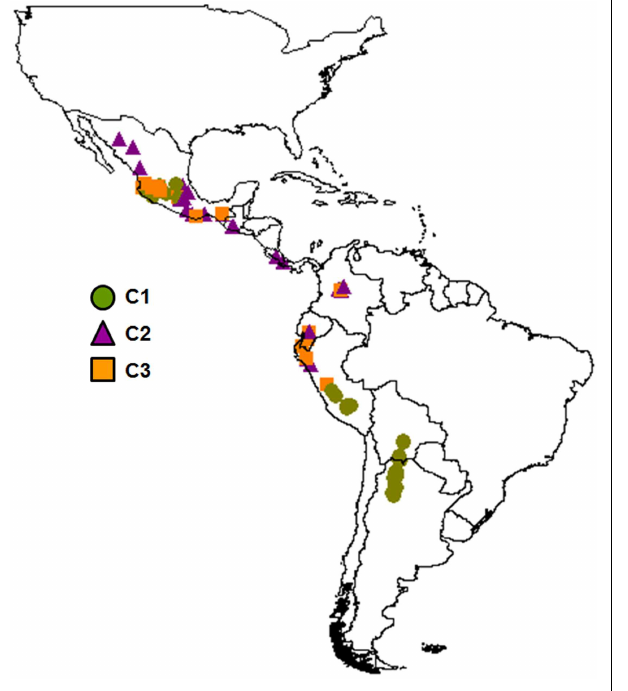
FIGURE 4 | Geographical distribution of the P. vulgaris accessions based on the BAPS cluster membership.